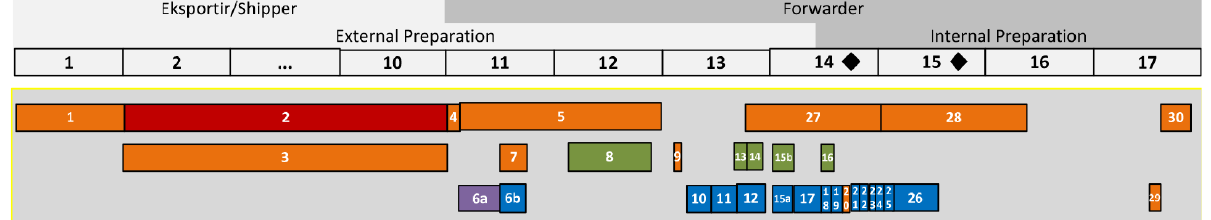
Figure 4. Time Table of Export